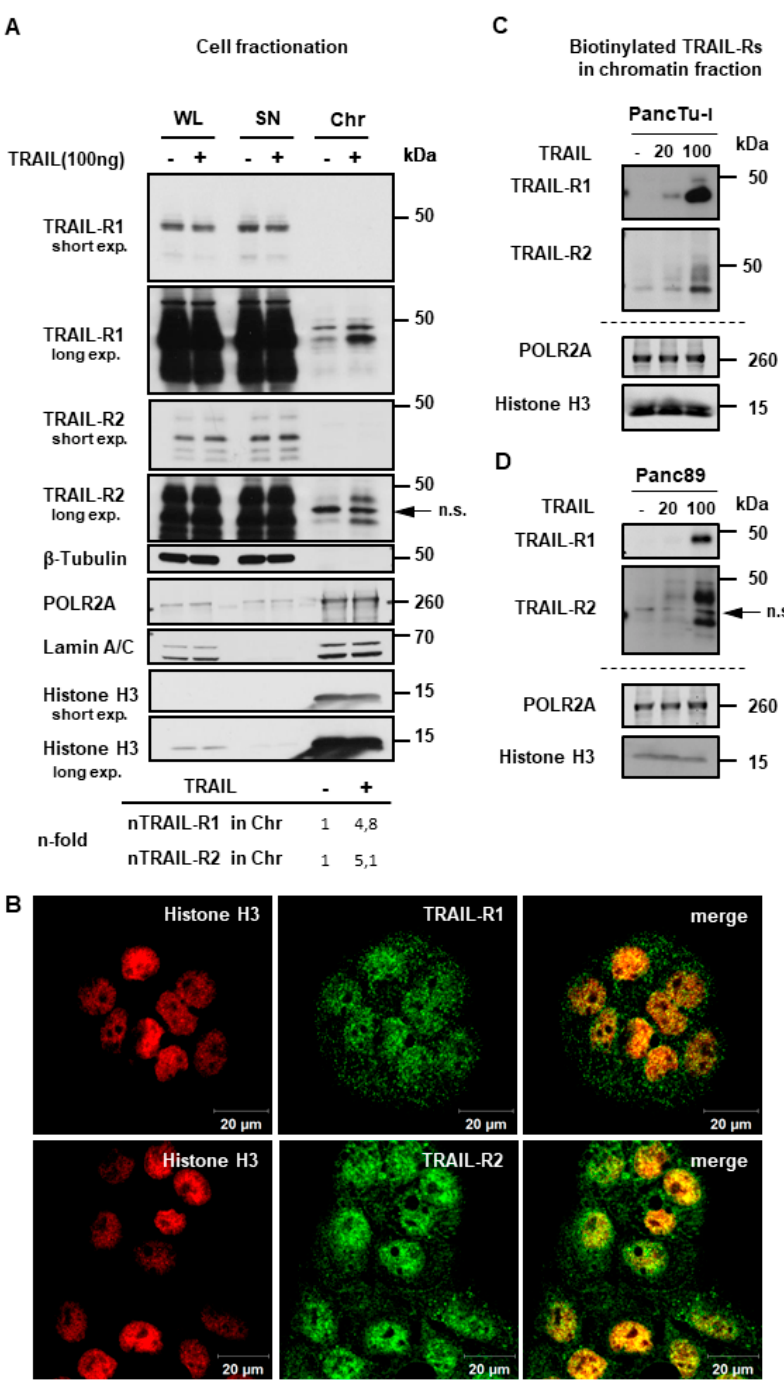
Figure 8. TRAIL-R1 and TRAIL-R2 are enriched in the chromatin fraction upon TRAIL stimulation. ( A ) PancTu-I cells were stimulated with 100 ng TRAIL for one hour. The obtained chromatin fractions (Chr) were analyzed by Western blotting and compared to the supernatant (SN) and to the whole cell lysate (WL). Markers for different subcellular fraction have been included as follows, β -Tubulin (cytoplasmic marker), RNA polymerase 2A (POLR2A) and Histone H3 (chromatin markers), Lamin A/C (nuclear marker). Band intensities of nTRAIL-R1 and nTRAIL-R2 bands were analyzed by densitometry in relation to POL2A and normalized to untreated controls. ( B ) Co-localization of TRAIL-R1 or TRAIL-R2 with Histone H3 in PancTu-I cells was studied by immunofluorescence and confocal LSM. ( C , D ) Plasma membrane proteins of PancTu-I and Panc89 cells were labeled with biotin for 1 h at 4 °C, followed by 1 h incubation at 37 °C with or without